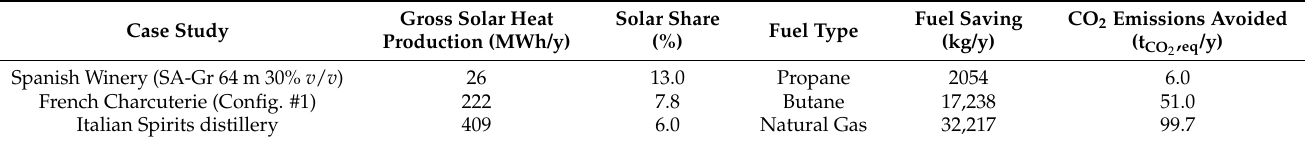
Table 5. Solar thermal production KPIs of configurations with highest solar share at every